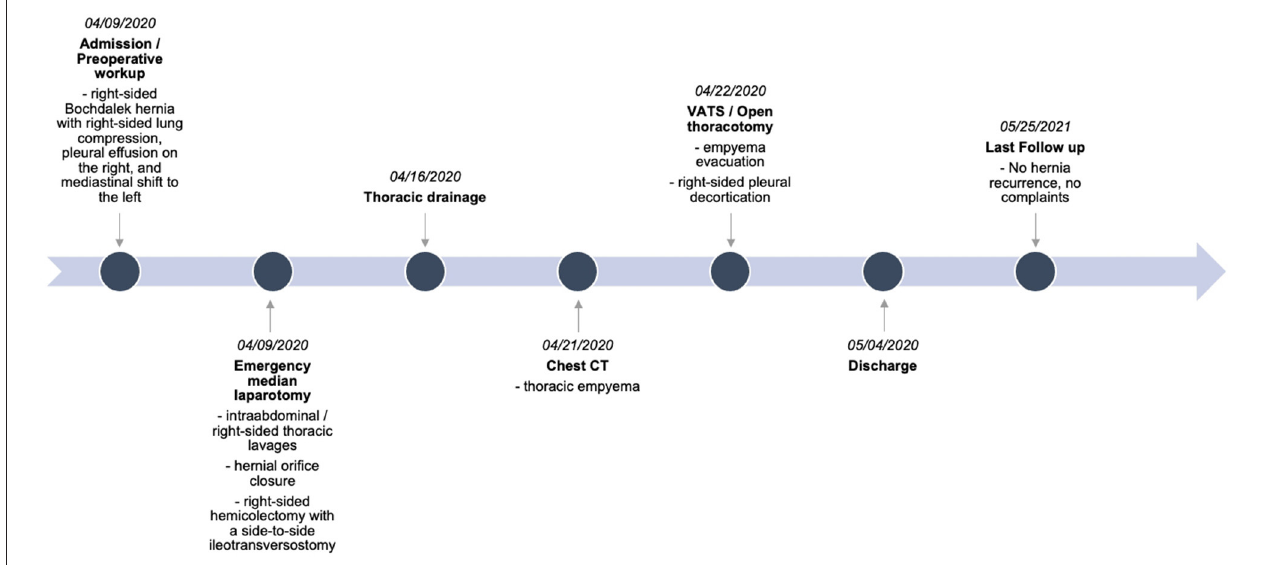
FIGURE 4 | Timeline of pre-operative workup, hospitalization, and follow-up. Computed tomography (CT), video-assisted thoracoscopy